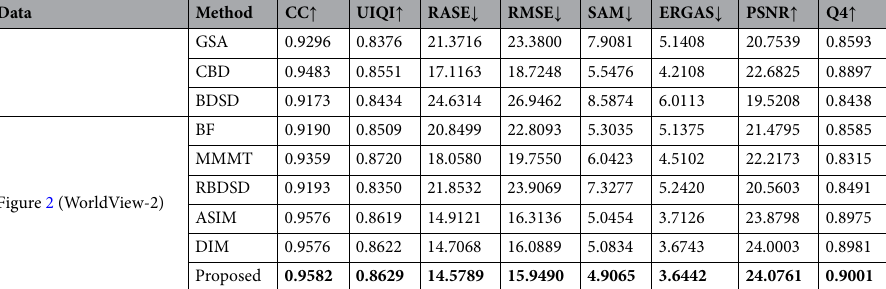
Table 3. Objective evaluation of the simulation experimental results shown in Fig. 2. Significant values are in [bold].